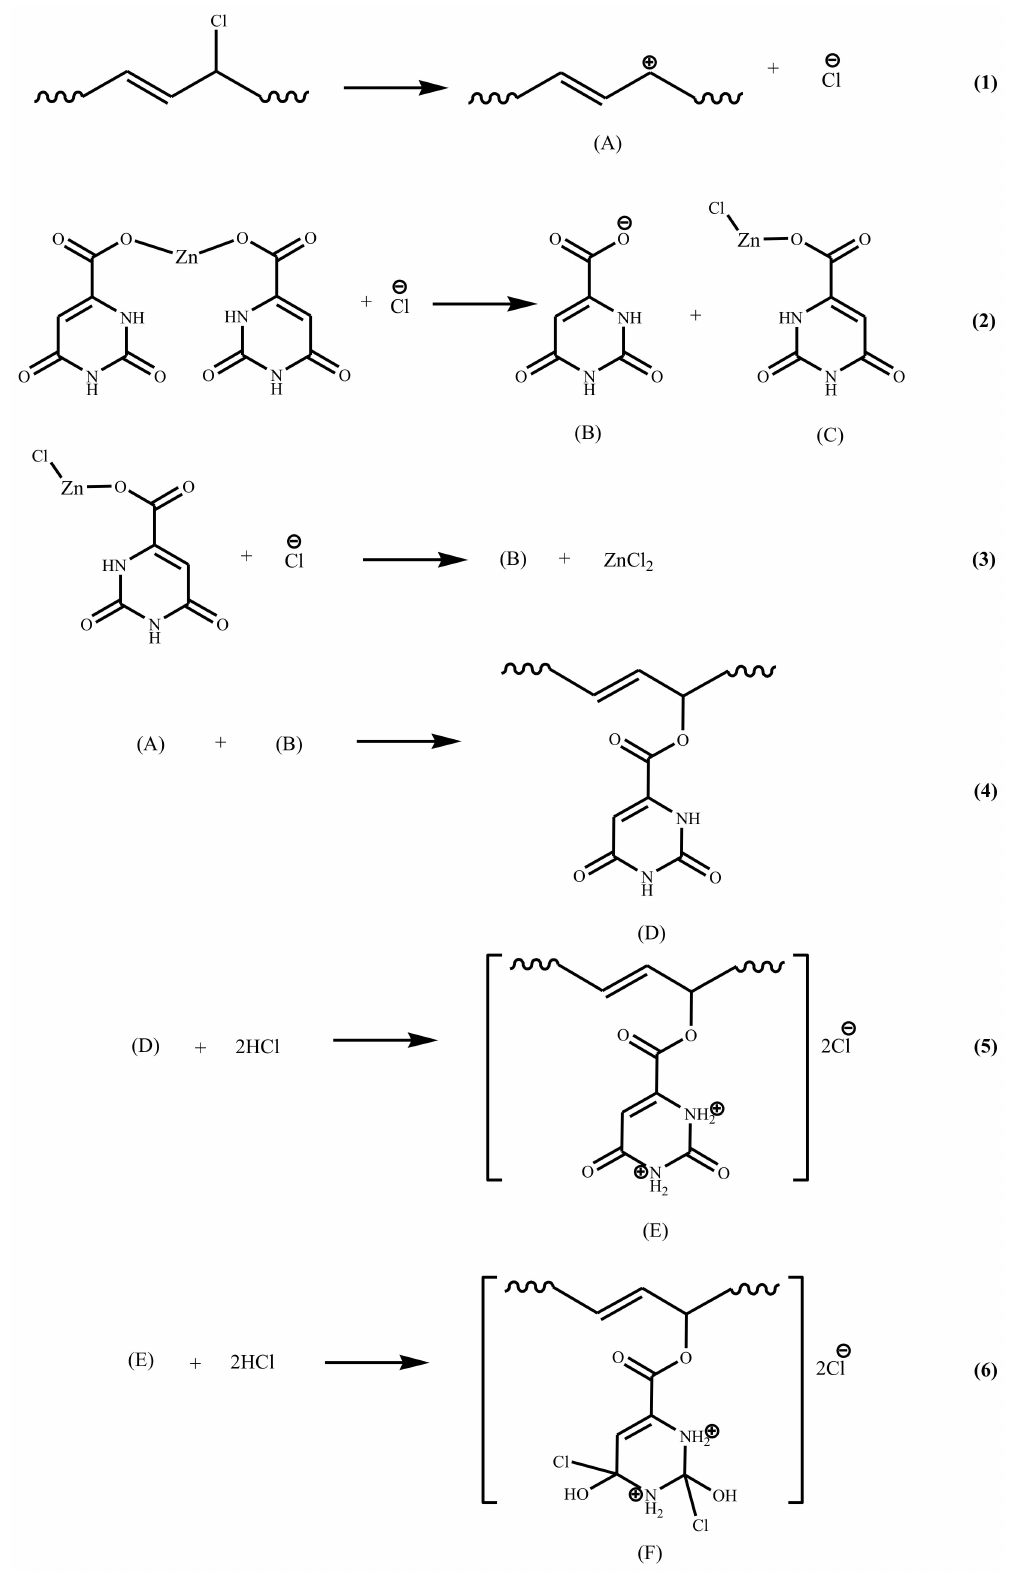
Scheme 2. The mechanism process of ZnOr 2 applied to stabilize